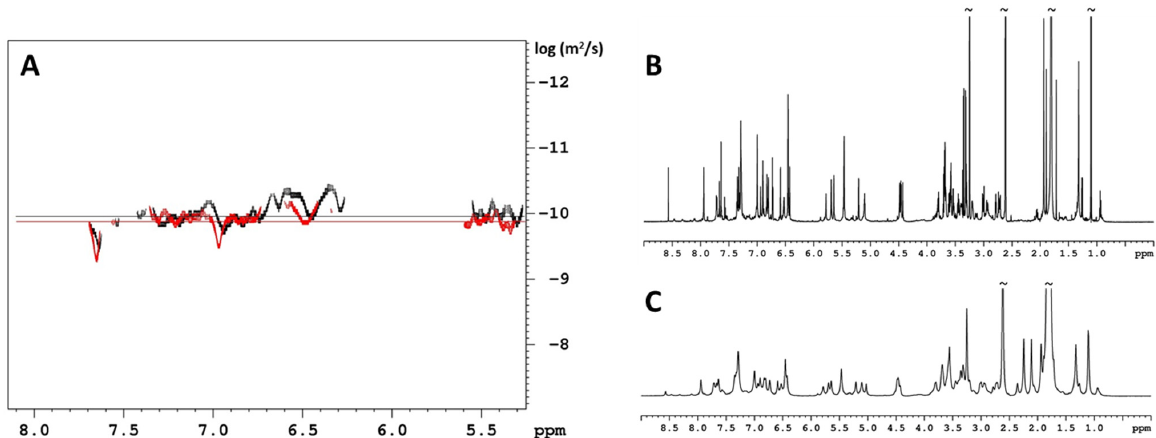
Figure 3. 500 MHz 1 H DOSY and 1 H NMR spectra. ( A ) Overlay of DOSY plots of 20 (red) and its Co-complex 21 (black). The slightly slower diffusion of 21 supports the formation of dimeric species. ( B ) and ( C ) 1 H NMR spectra of 20 and 21 , respectively. The line-broadening observed in the 1 H NMR spectrum of 20 (shown in C ) upon addition of Schiff base cobalt diammine indicates a monomer-dimer equilibrium in the intermediate regime on the 1 H NMR timescale.